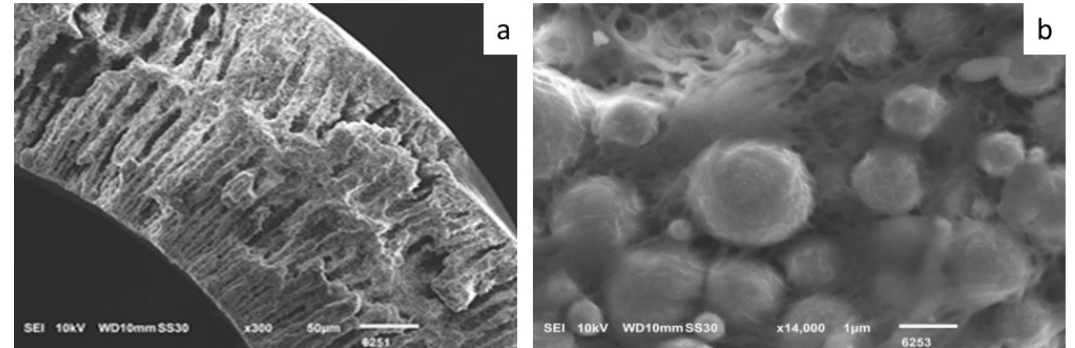
Figure 1. SEM image of the cross section of the Cu hollow fiber after spinning at low ( a ) and high ( b ) magnification. The scale bar indicates 50 or 1 µm, respectively.